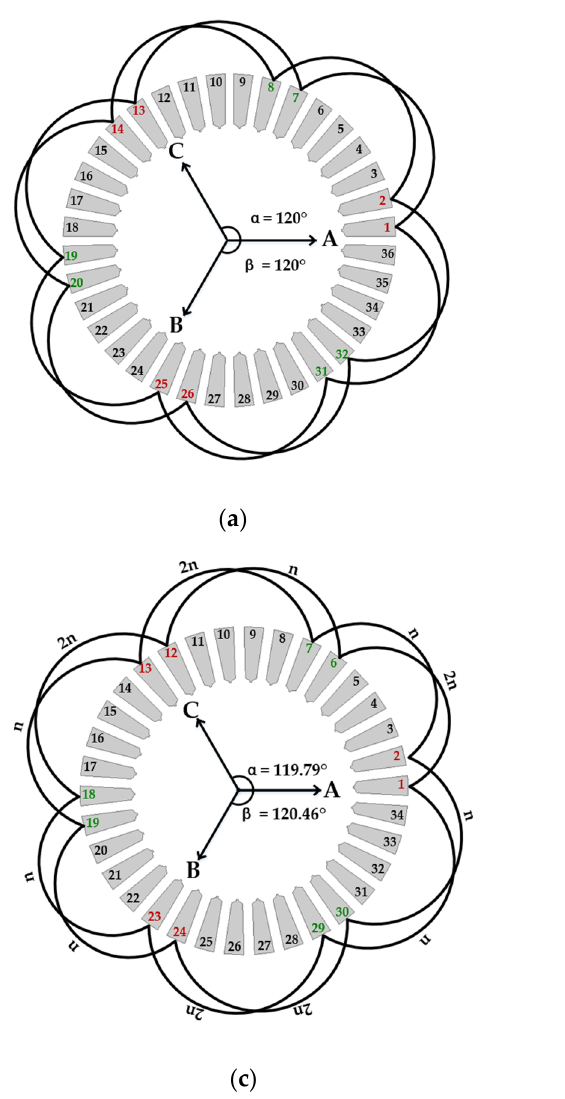
Table 11. Slot distribution to phases of M 4 .